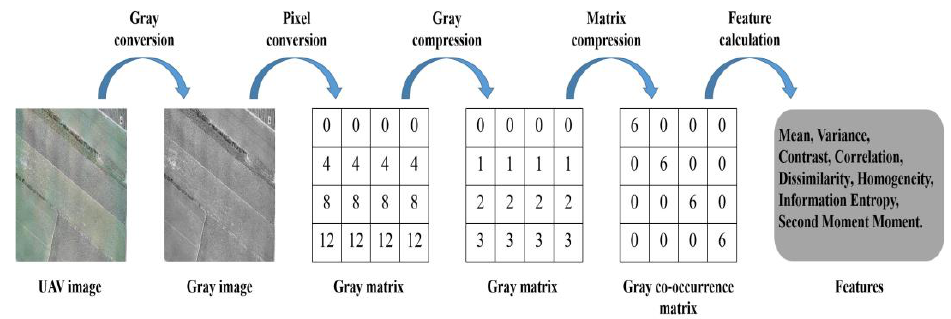
Figure 7. Sketch of feature extraction process of gray scale co-occurrence matrix.